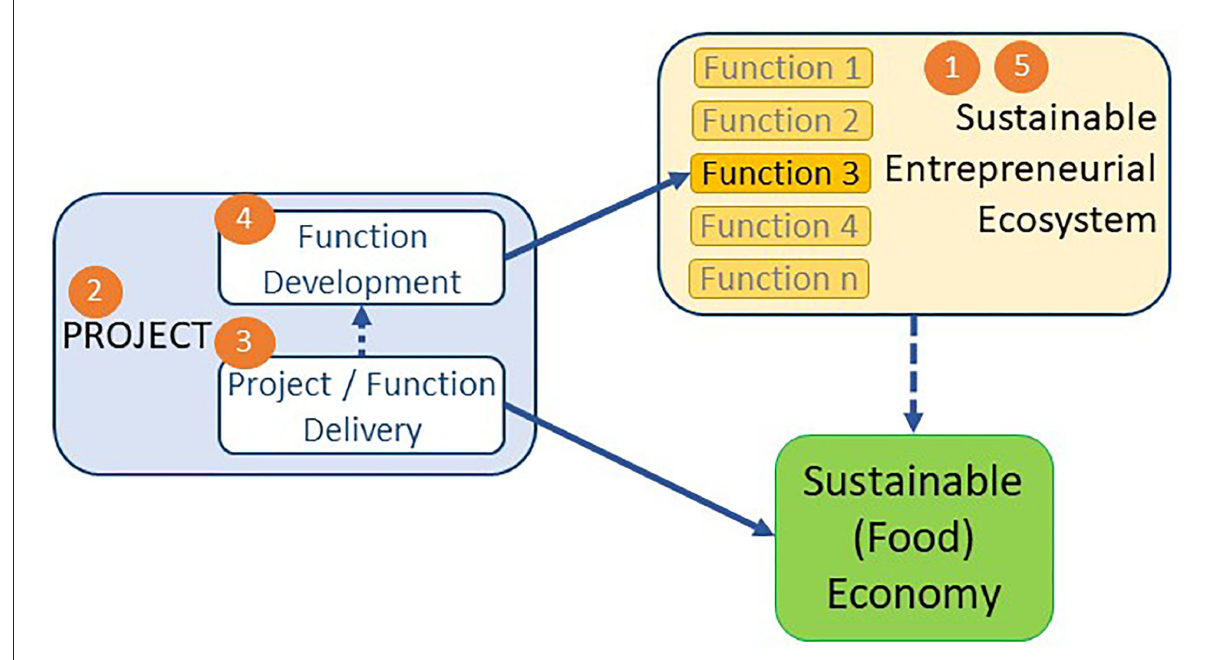
TABLE 3 The state of Phoenix area SEE functions in 2017 (baseline) with number of actors involved in each function, appraisal of criteria for function strength, and overall function performance level (0 = missing, 1 = minimal, 2 = intermediate, 3 = full). Function Number of actors Sustainability Inclusivity Capacity Stability Level Consulting 7 Medium Medium Medium Medium 1 Marketing 3 Medium Medium Medium Medium 1 Networking 14 Weak Medium Medium Medium Capacity building 10 Weak Strong Medium Medium Cultivating 7 Weak Strong Medium Medium Policy making 7 Weak Medium Medium Weak Advocating Weak Medium Material provision Financing